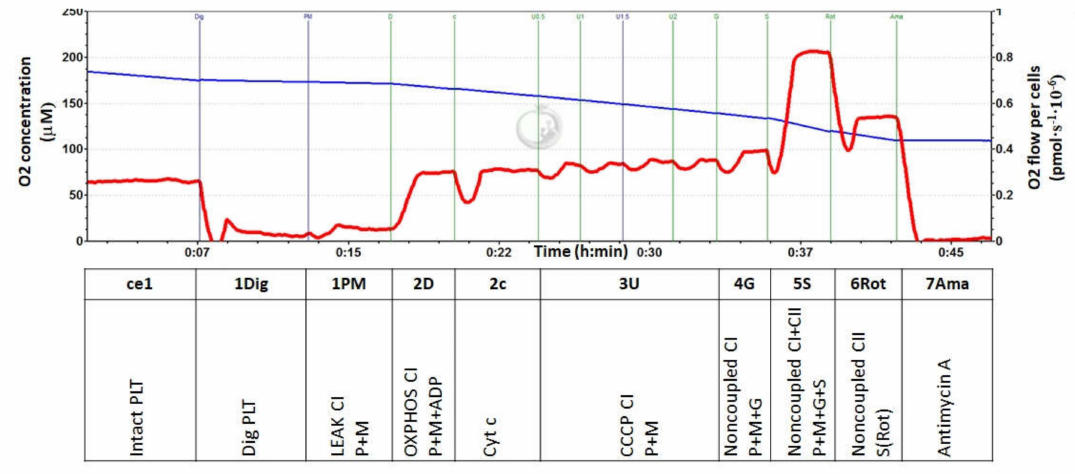
Figure 1. Respirometric analysis of mitochondrial function in human platelets. Legend: The trace from themeasurementofplatelet(PLT)respirationat37 ◦ CinarespirationmediumMiR05and20mMcreatine. Blue line represents oxygen concentration ( µ M), and the red trace represents oxygen consumption as flow per cells (pmol O 2 · s − 1 · 10 − 6 cells). The modified (substrate-uncoupler-inhibitor-titration)